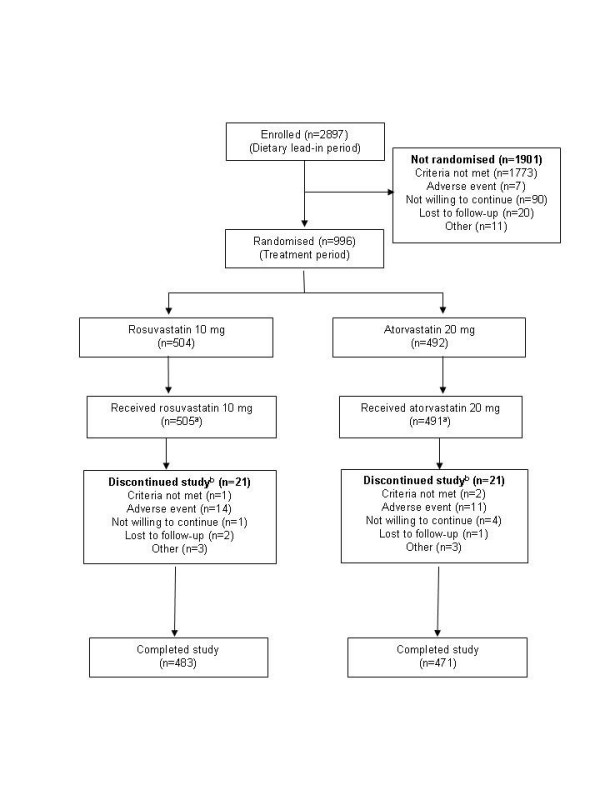
Patient populations. aOne patient randomized to atorvastatin 20 mg received rosuvastatin 10 mg. bBased on intention-to-treat populations (n = 504 for rosuvastatin 10 mg; n = 492 for atorvastatin 20 mg).